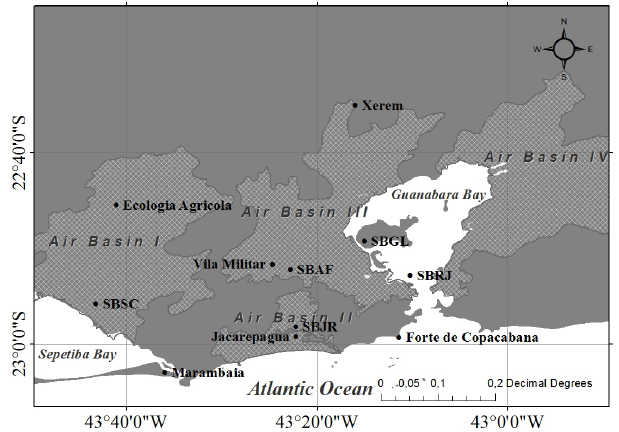
Figure 1. The MARJ air basins and the location of the surface weather-observation